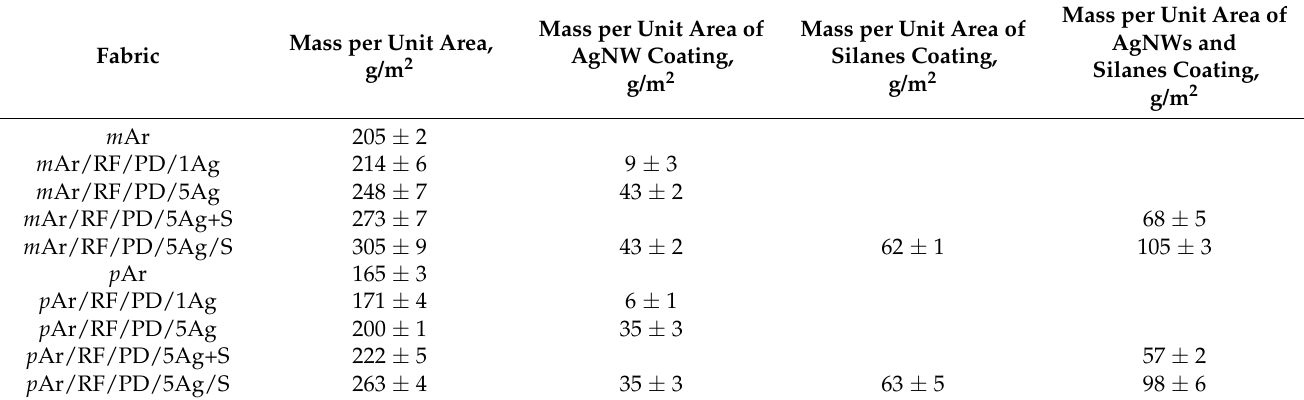
Table 1. Mass per unit area of the reference and modified aramid